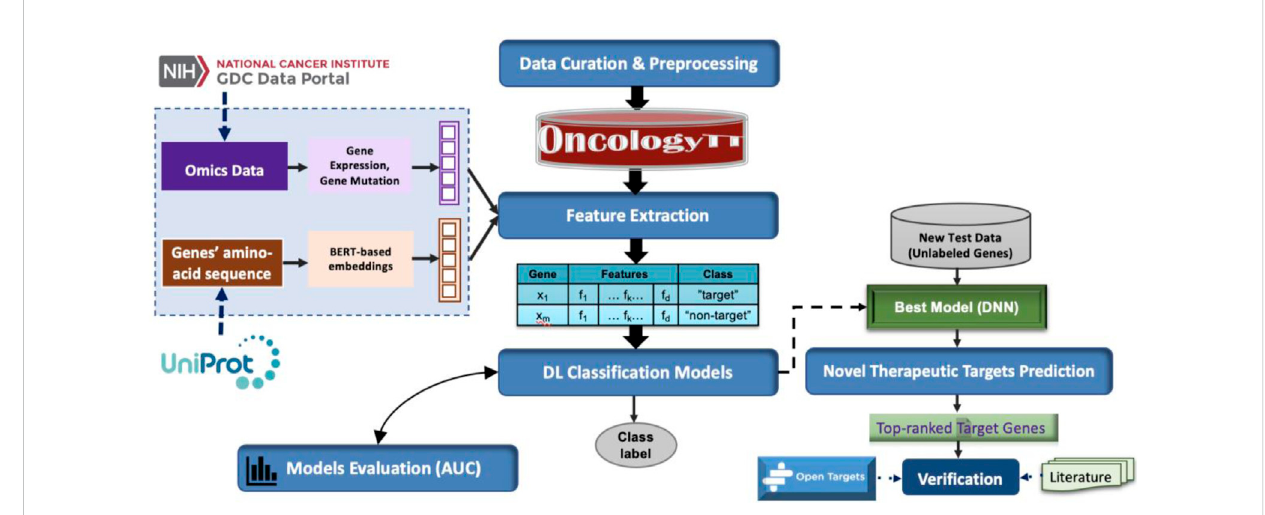
FIGURE 2 The work fl ow used to build the OncoRTT model consists of six main